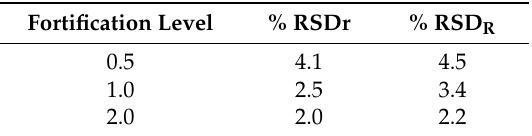
Table 1. Results of intra- and inter-day precision in three different fortification levels.